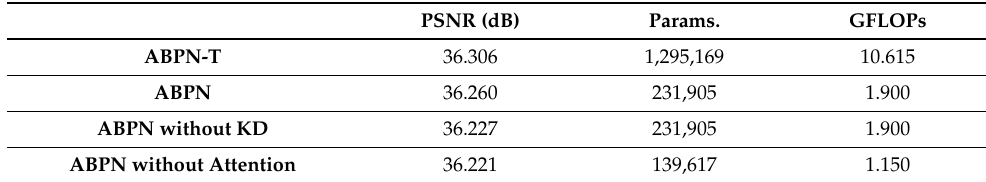
Table 6. The performance comparison between the teacher model of ABPN, lightweighted ABPN, and ABPN without KD strategy or attention mechanism.